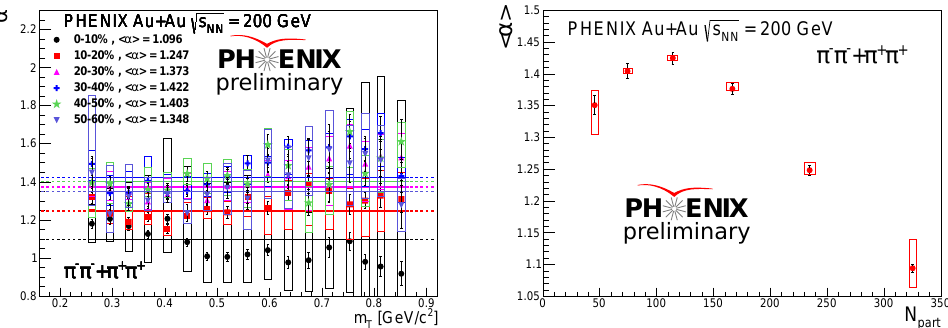
Figure 3. The α Lévy stability parameter as a function of m T ( left ); The (cid:104) α (cid:105) as a function of N part ( right ). The statistical errors are shown with errorbars and the systematical uncertainties